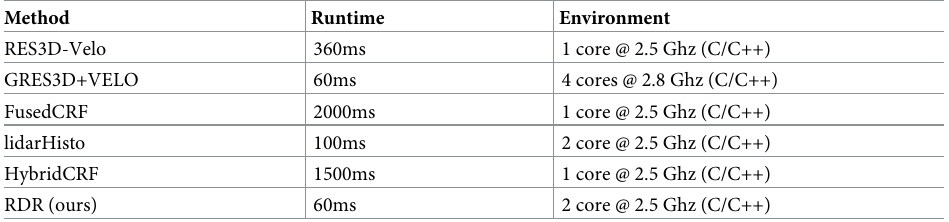
Table 2. Time efficiency comparison.